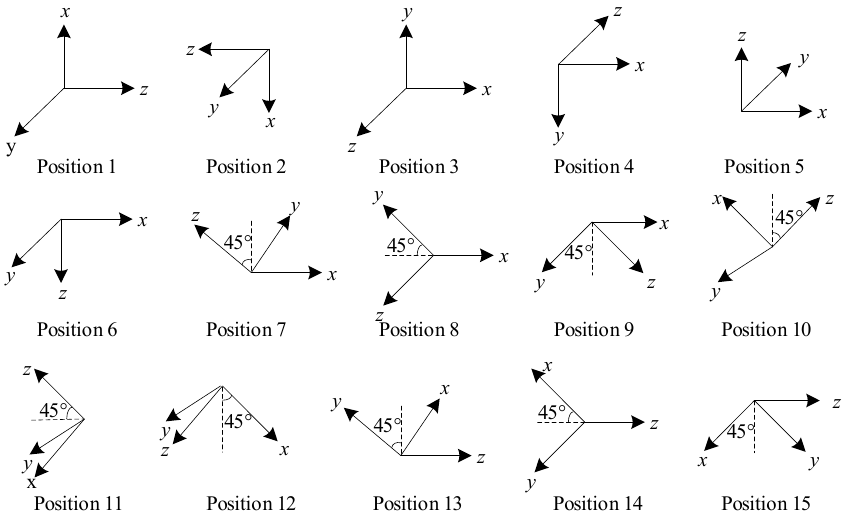
Figure 2. The 15 optimal position clusters.